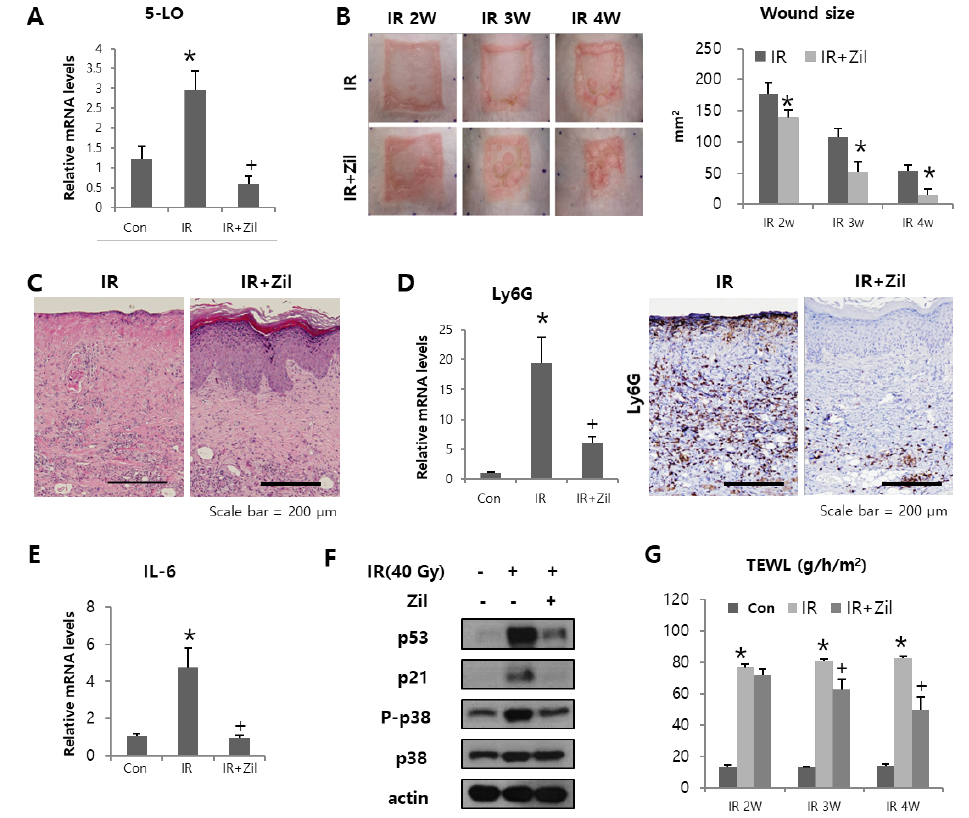
Figure 5. Effect of zileuton in a mouse model of radiation skin injury. Six mice per group were used. ( A ) 5-LO mRNA levels in mouse skin in control (Con), irradiated (IR), and zileuton-treated irradiated (IR+Zil) mice. Data are presented as mean ± standard error, with statistical significance set at * p < 0.05 vs. control group (Con), + p < 0.05 vs. irradiated group (IR). ( B ) Representative gross images of mouse skin and quantification of wound size. Data are presented as mean ± standard error, with statistical significance set at * p < 0.05 vs. irradiated group (IR). ( C ) Hematoxylin and eosin (H&E) staining of mouse skin. ( D ) mRNA levels ( left ) and representative immunostaining images ( right ) of Ly6G in mouse skin. Data are presented as mean ± standard error, with statistical significance set at * p < 0.05 vs. control group (Con), + p < 0.05 vs. irradiated group (IR). ( E ) mRNA levels of IL-6 were measured by qRT-PCR. Data are presented as mean ± standard error, with statistical significance set at * p < 0.05 vs. control group (Con), + p < 0.05 vs. irradiated group (IR). ( F ) Western blot analysis of p53, p21, p-p38, and p38 expression levels of mouse skin. ( G ) Transdermal water loss values of mouse skin. Data are presented as mean ± standard error, with statistical significance set at * p < 0.05 vs. control group (Con), + p < 0.05 vs. irradiated group (IR).